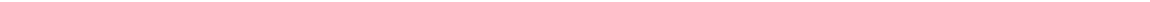
Fig. 2 HSP27 downregulation impairs myelo fi brosis progression in a JAK2V617F murine model. a In vivo strategy of HSP27 inhibition using OGX-427 or a vehicle, injected intraperitoneally 3 times a week at a dose of 10 mg kg − 1 in a JAK2V617F murine model of myelo fi brosis (MF). Mice were 2 months old. b Spleen weight was evaluated in mice ( n = 5 per group). Outcomes of the two treatments were compared using the Mann – Whitney test. * P < .05. Error bars represent ±s.e.m. c Western blot analysis of HSP27 in bone marrow (whole cell lysate) of MF mice treated with OGX-427 or vehicle. Actin served as the loading control. Bar graphs show quanti fi cation of mean relative amount of the proteins ( n = 3 per group). Uncropped blots presented in Supplementary Fig. 7a. d Percentage of megakaryocytes progenitors (MkPs) present in the bone marrow or spleen, error bars represent ±s.e.m. ( n = 5 per group). P values were calculated using the Mann – Whitney test. * P < .05. e Upper panel, Gordon and Sweet-stained bone marrow sections revealed reduced reticulin fi brosis in MF mice and in OGX-427-treated mice. Lower panel, assessment of the fi brosis grade from bone marrow sections of 5 mice per group. Pie chart: Grade 1 (light pink): few thin reticulin fi bres. Grade 2 (light red): networks of thin reticulin fi bres. Grade 3 (purple): dense network of thick reticulin fi bres. Images were obtained using a Nanozoomer scanner (Hamamatsu, France) at ×23 magni fi cation and Calopics software. f Blood cell parameters assessed in mice before and after OGX-427 ( n = 5) or vehicle treatment ( n = 5) and on the day of killing. WBC white blood cells. Error bars represent ±s.e.m. P values were calculated using the Mann – Whitney test. * P < .05; ** P < .01. *** P <